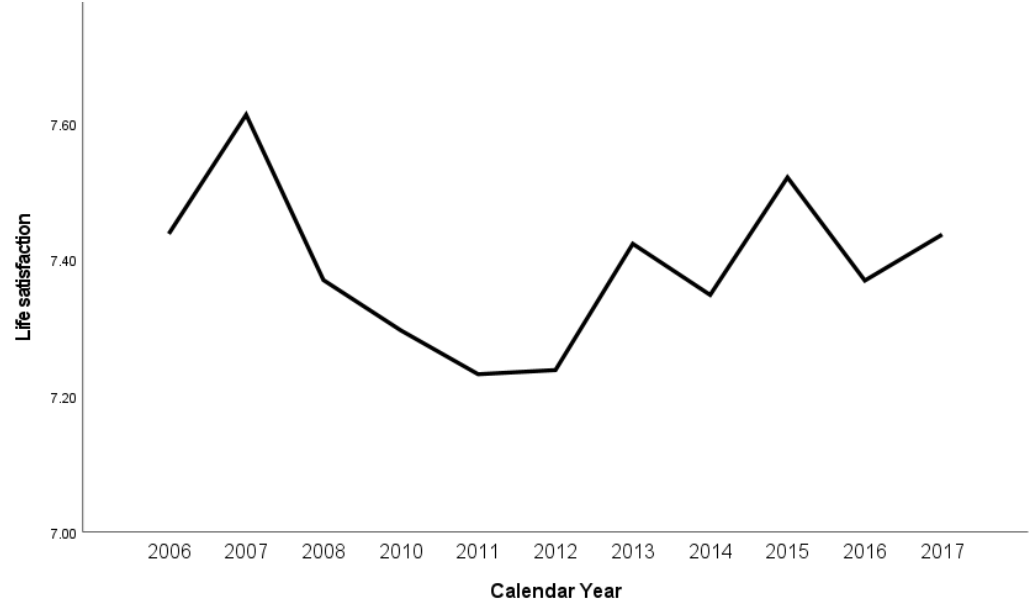
Figure 2. Prevalence of life satisfaction in New Zealand from 2006 to 2017. Between 2006–2017 mean life satisfaction varied from a high of 7.61 ( SD = 1.6) in 2007 to a low of 7.23 ( SD = 1.73) in 2011; the range in mean changing 0.38 over this time between the high and